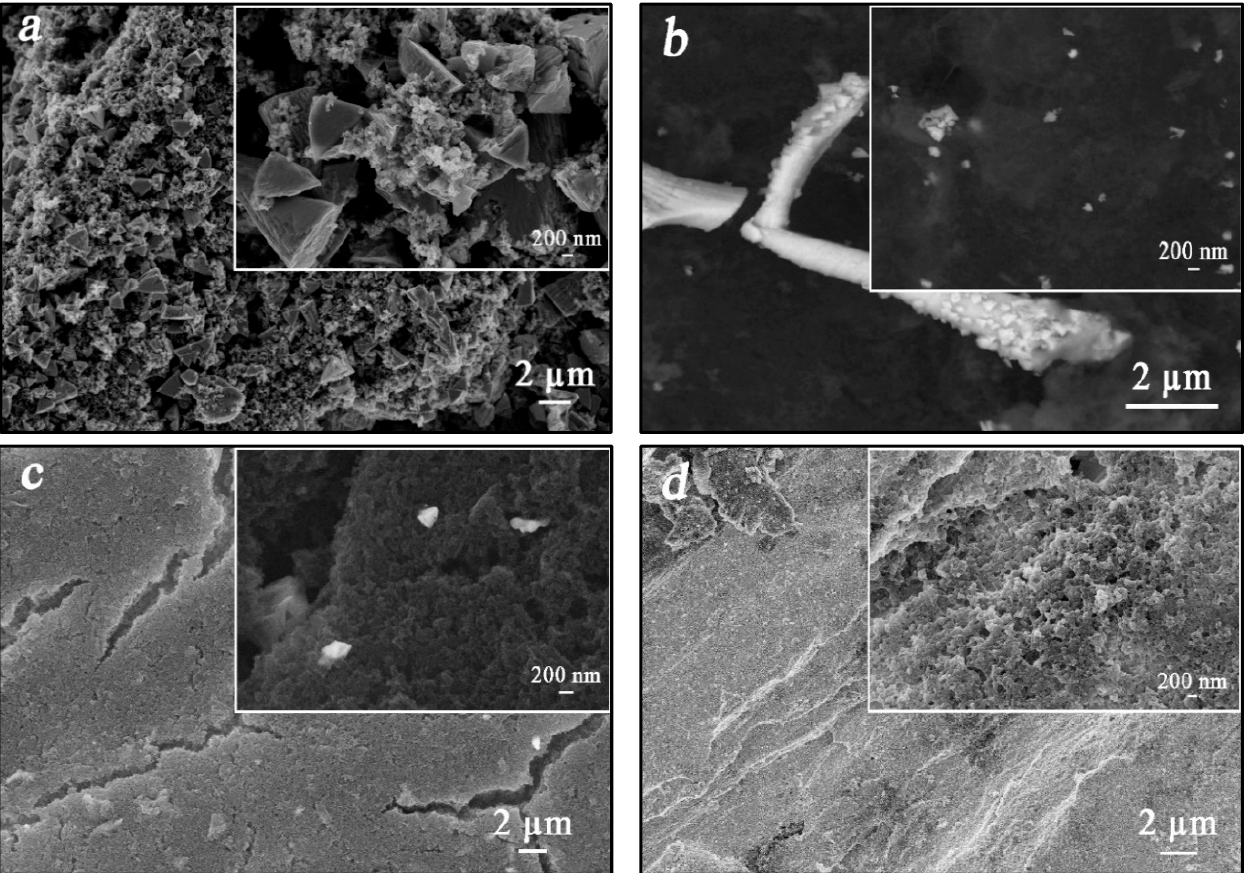
Figure 2. SEM images of CuI-PPy composites: ( a ) sample 3, ( b ) sample 4, ( c ) sample 6, ( d ) sample 7. The description of samples is specified in Table